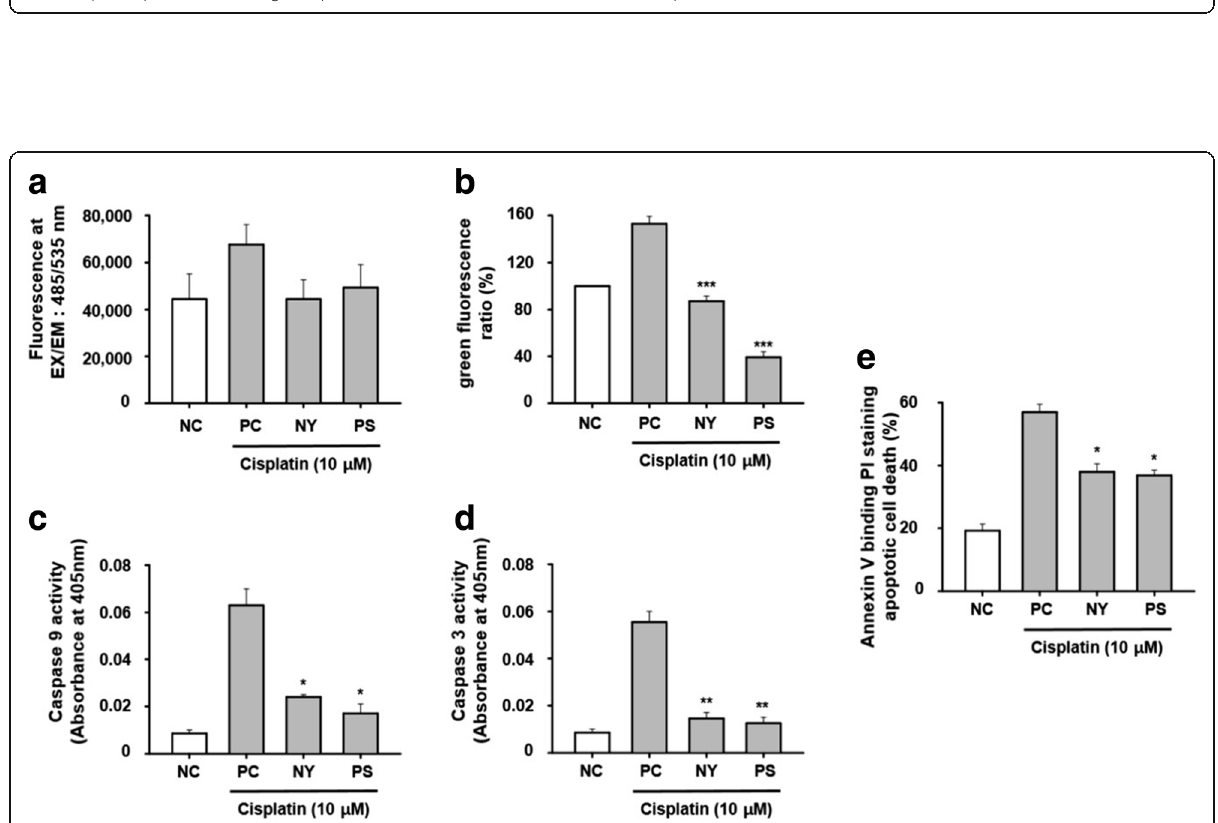
Fig. 4 Fold-change of kidney injury biomarkers after high- and low-dose cisplatin treatment. HMGB1 ( a ), NGAL ( b ) and KIM-1 ( c ) levels are shown for cells treated with 400 μ M cisplatin for a short exposure time (2 to 6 h). HMGB ( d ), NGAL ( e ) and KIM-1 ( f ) levels were measured in cells treated with 10 μ M cisplatin and a longer exposure time (6 to 48 h). The data were compared with the control condition